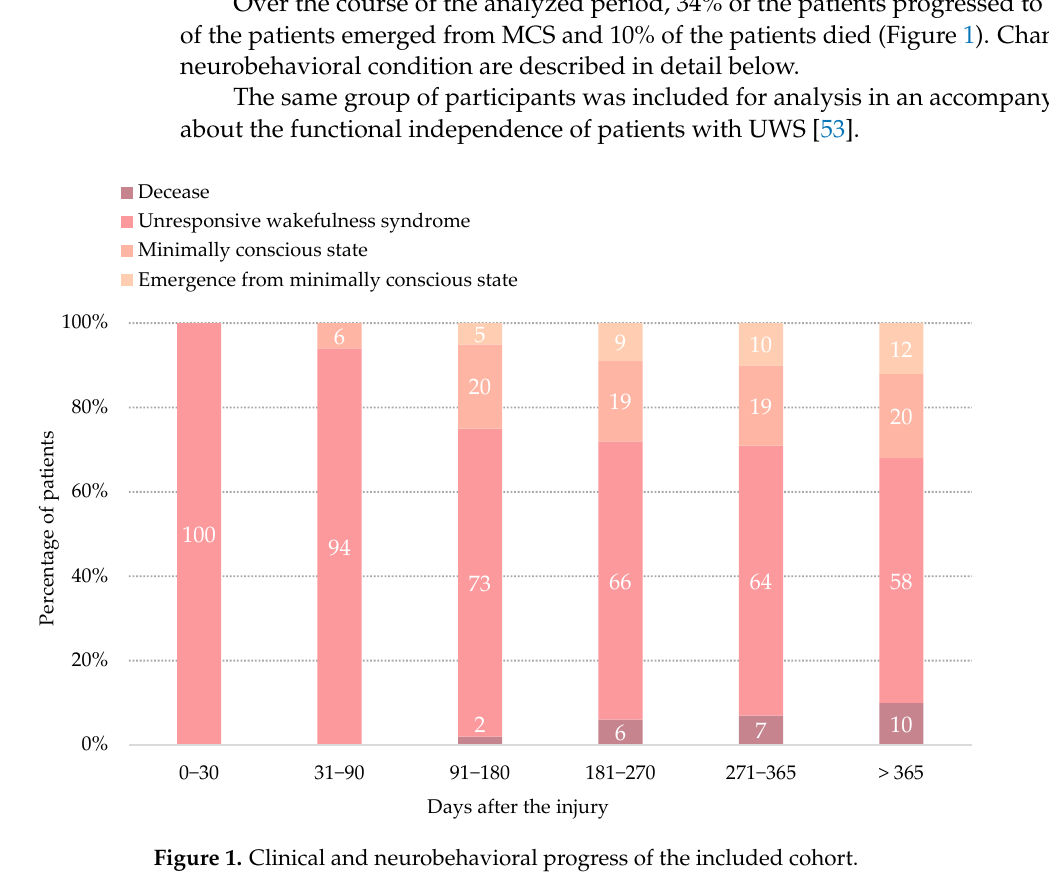
Figure 1. Clinical and neurobehavioral progress of the included cohort.